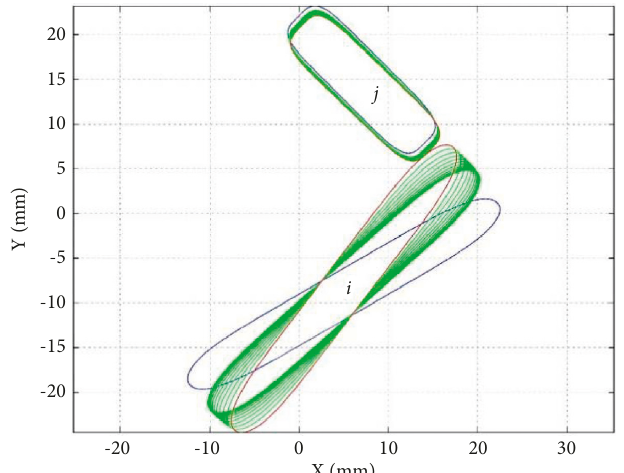
Figure 4: Collision process of superellipses i and j .